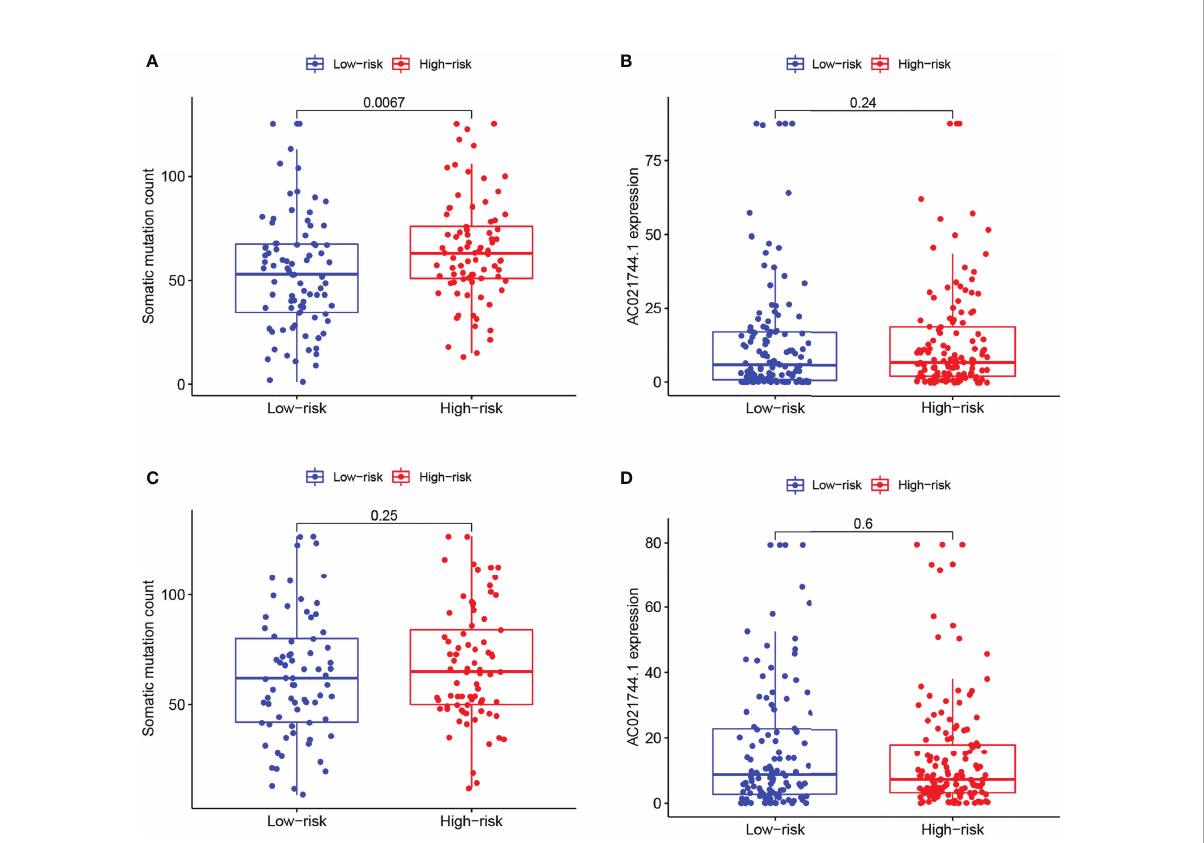
FIGURE 5 Risk correlation analysis. (A, C) Boxplots of correlation between risk levels and somatic mutation count in training group and testing group. (B, D) Boxplots of correlation between risk levels and AC021744.1 expression in training group and testing